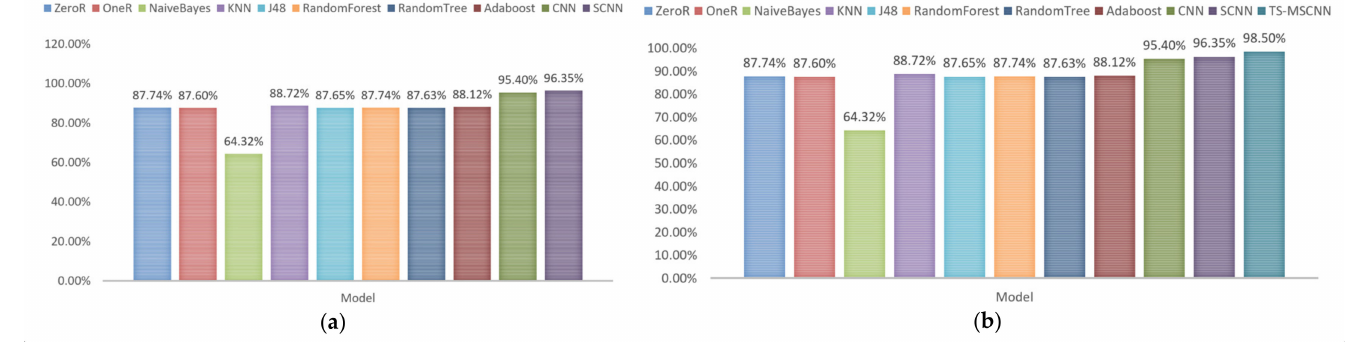
Figure 14. ( a ) Performance of the single model. ( b ) Performance of the TS-MSCNN and other models.